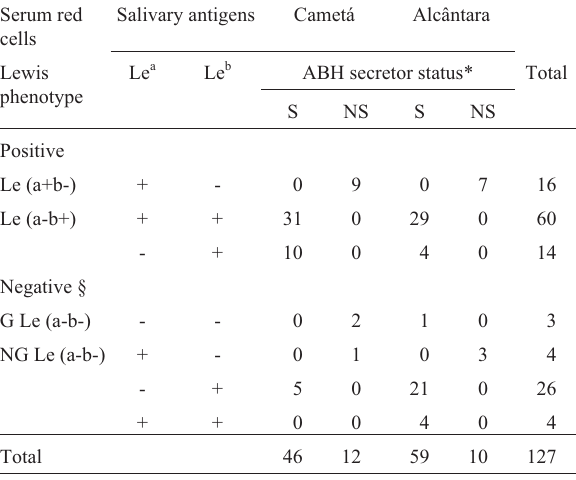
Table II - Distribution of Lewis blood groups and salivary secretor phenotypes in Brazilian Black populations. Serum red